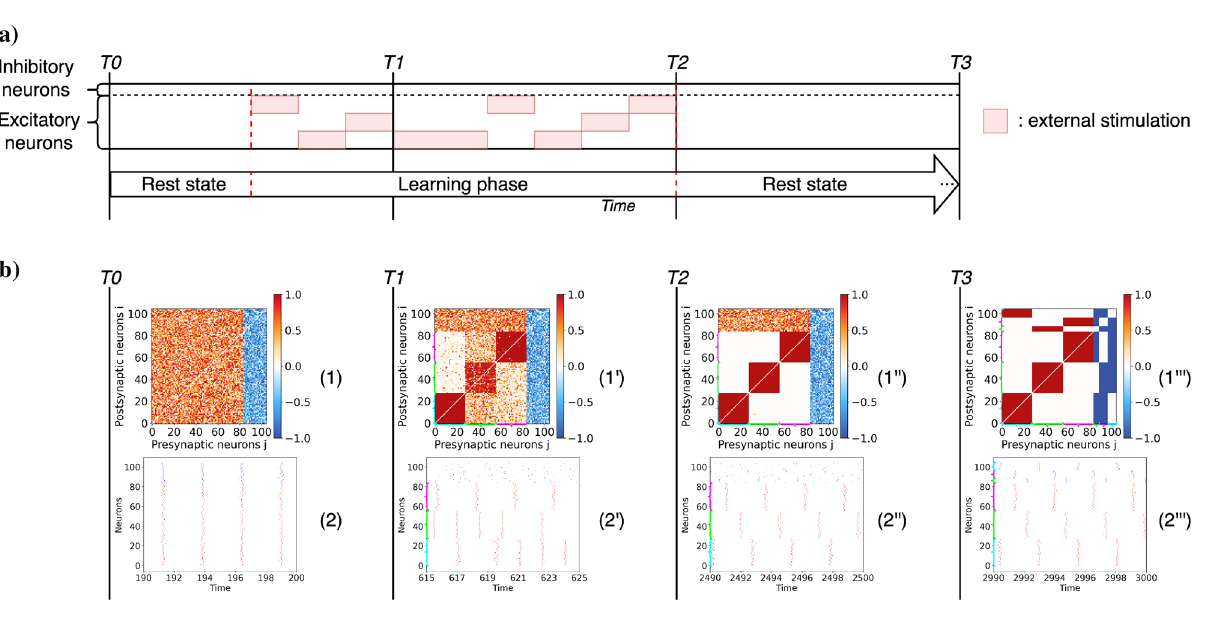
Figure 5. Entrainment of a network of excitatory and inhibitory θ -neurons with three stimuli. ( a ) Stimulation protocol of the excitatory neurons by three different and non-overlapping stimuli. ( b ) Entrainment results at different instances of the simulation. The time labels and the graphs have the same significance and content as in Fig. 3. Inhibitory neurons are sorted by phases at time T3 for visualization purposes. The cyan, green and magenta brackets represent clusters 1, 2 and 3 respectively when they are visible in weight matrices and raster